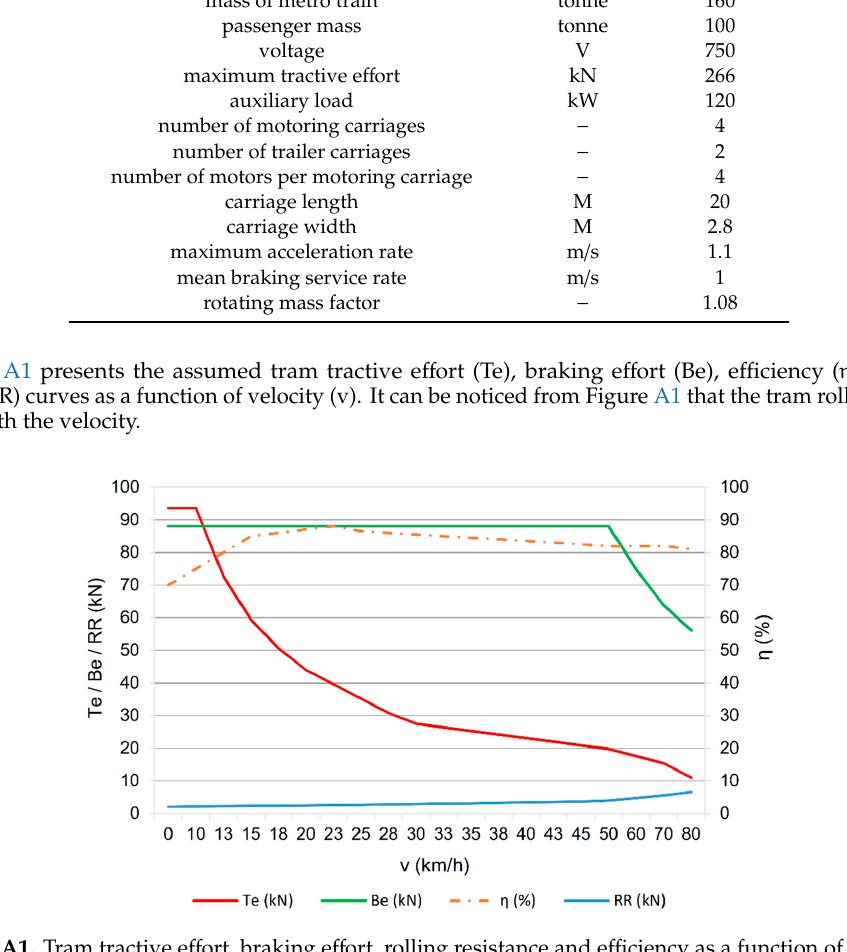
Figure A1. Tram tractive e ff ort, braking e ff ort, rolling resistance and e ffi ciency as a function of velocity.